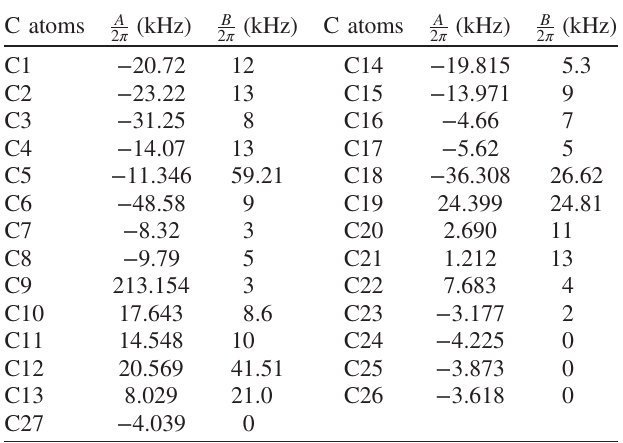
TABLE V. Hyperfine parameters of the 13 C atoms we consider in Sec. IV